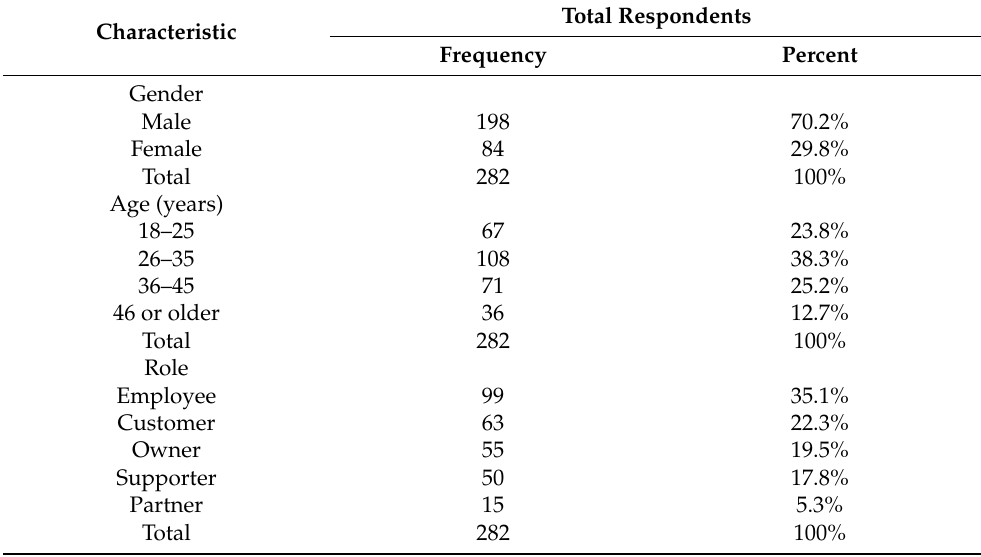
Table 2. Demographic characteristics of